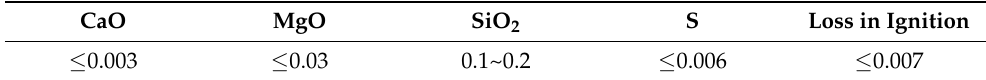
Table 1. Chemical composition of limestone